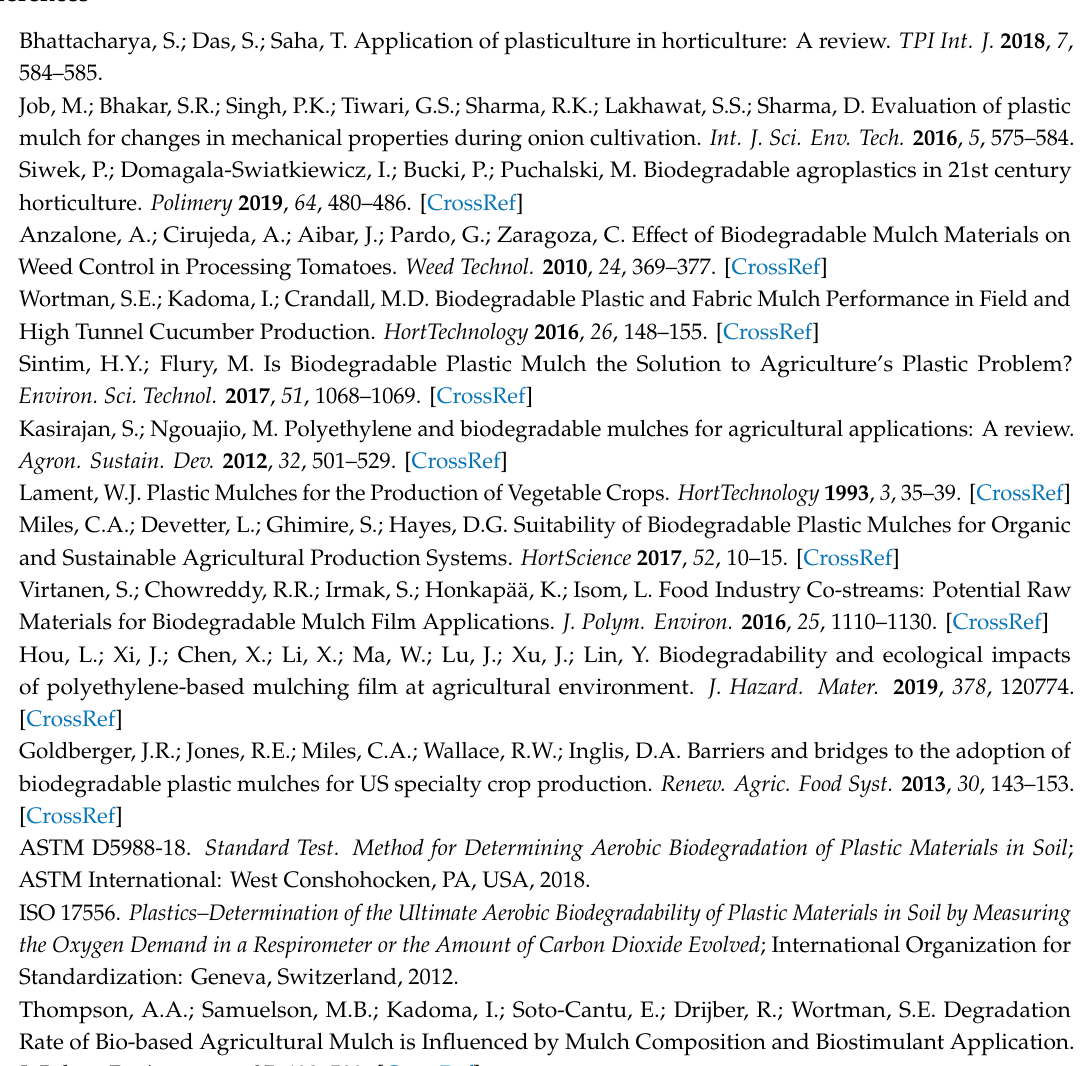
bias and a red dot above a short dash line in the DFFITS plot identifies potentially influential observations. Figure S6: Funnel plots (top) and di ff erence in fits (DFFITS) values (bottom) for each observation contributing to the mean weed response ratio for paper (left) and starch (right) mulch types. Significant asymmetry in the funnel plot suggests possible publication bias and a red dot above a short dash line in the DFFITS plot identifies potentially influential observations. Figure S7: Funnel plots (top) and di ff erence in fits (DFFITS) values (bottom) for each observation contributing to the mean yield response ratio for bare soil (left) and other (right) mulch types. Significant asymmetry in the funnel plot suggests possible publication bias and a red dot above a short dash line in the DFFITS plot identifies potentially influential observations. Figure S8: Funnel plots (top) and di ff erence in fits (DFFITS) values (bottom) for each observation contributing to the mean yield response ratio for paper (left) and starch (right) mulch types. Significant asymmetry in the funnel plot suggests possible publication bias and a red dot above a short dash line in the DFFITS plot identifies potentially influential